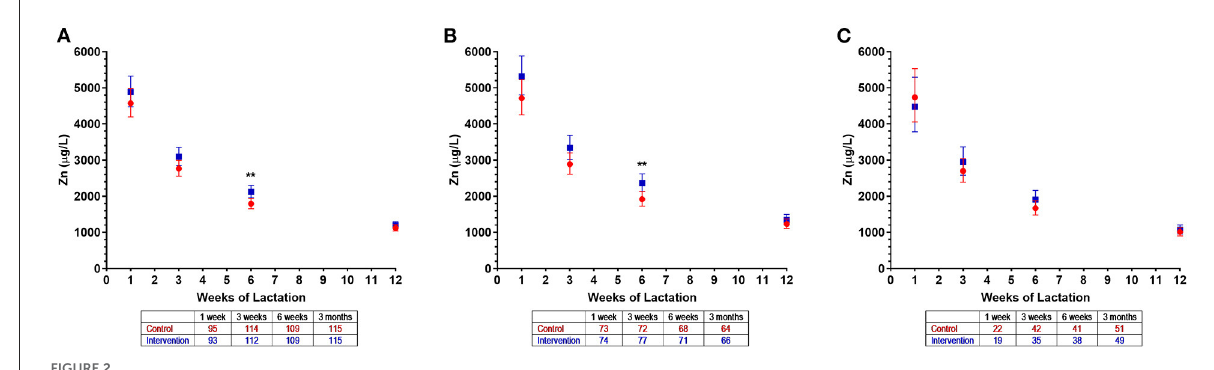
FIGURE2 Zinc concentrations in human milk of control ( ) and intervention ( ) groups in the NiPPeR study during the first 3 months of lactation: (A) Overall, (B) Singapore, and (C) New Zealand. Data are the least-squares means (i.e., adjusted means) for each group, adjusted for visit, an interaction term (group*visit), study site, adherence, maternal pre-pregnancy body mass index, and gestational age at birth; error bars represent the respective 95% confidence intervals. ** p < 0.01 for the difference between intervention and control groups at a given time point. The number of HM samples per group analyzed at a given time point are provided in the tables below the x